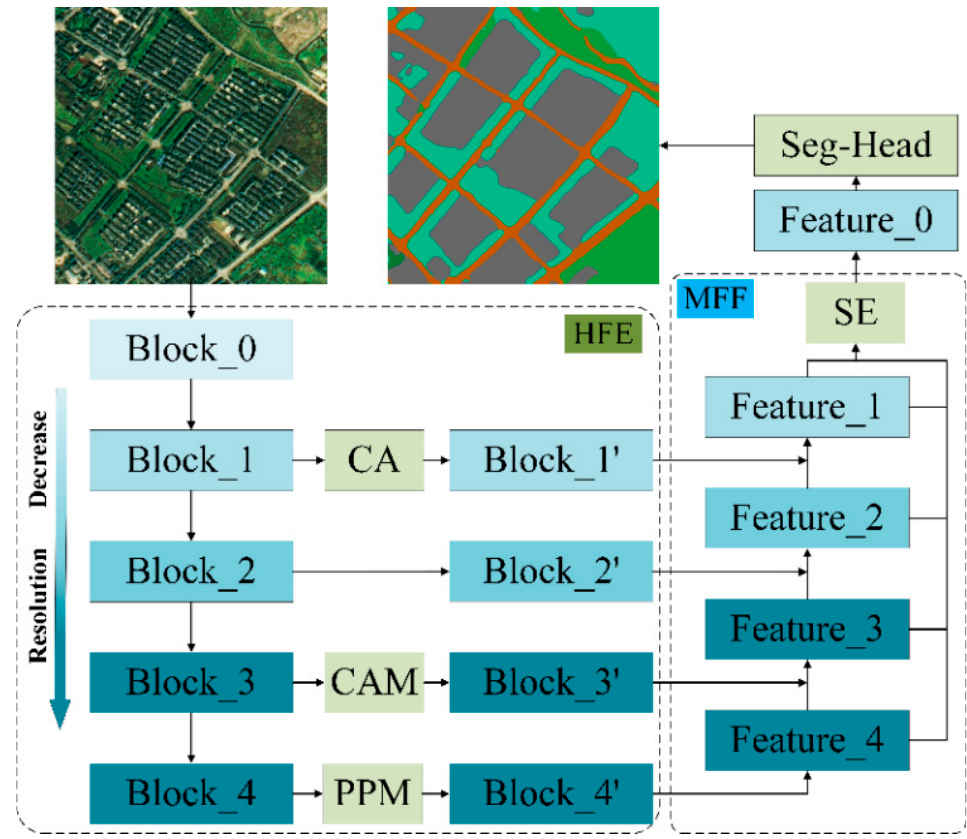
Figure 1. The overall framework of HFENet.